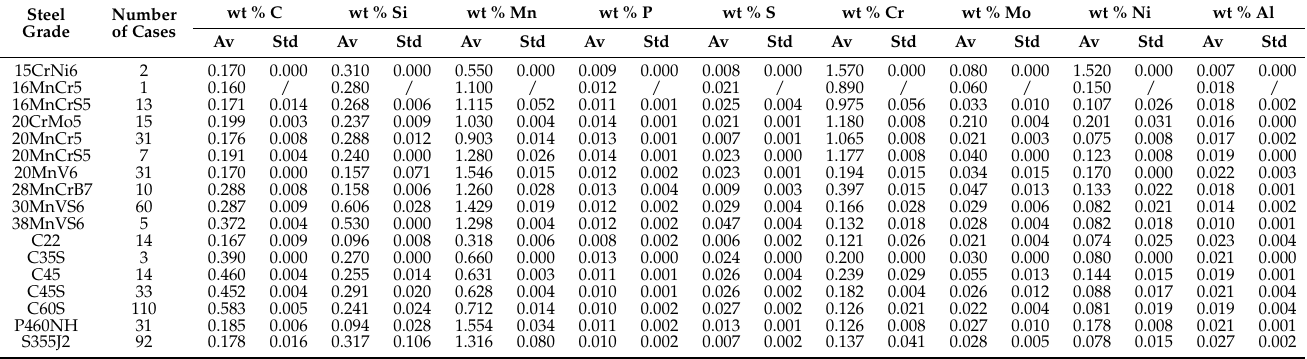
Table 1. The chemical composition (average and standard deviation) of steel grades used in the research.